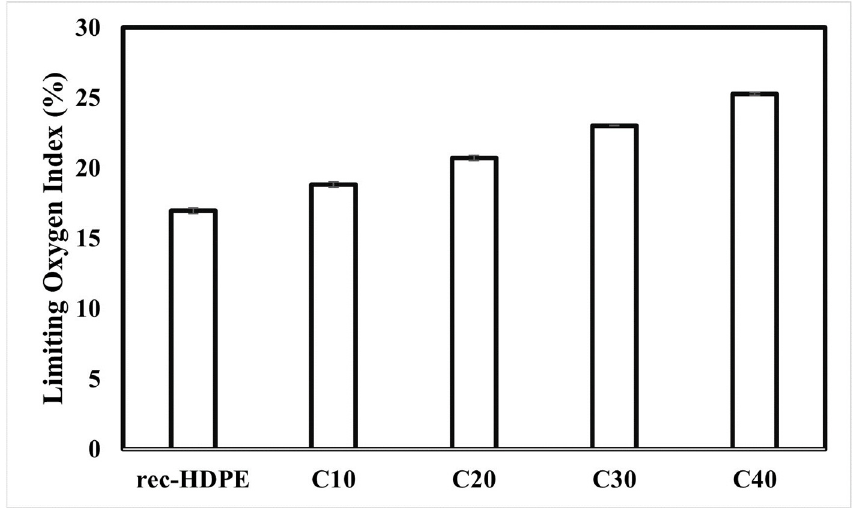
Figure 8. Limited oxygen index of the recycled HDPE and composites. Table 4. Fire retardant properties of the recycled HDPE and composites.